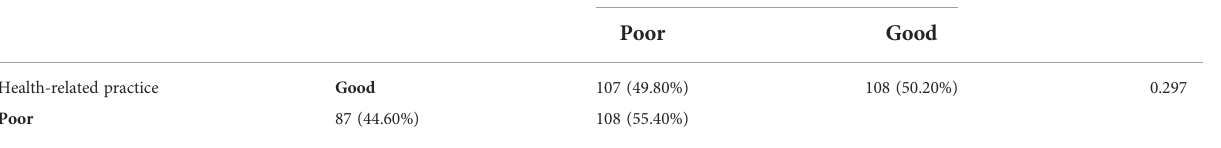
TABLE 5 Association between knowledge and health-related